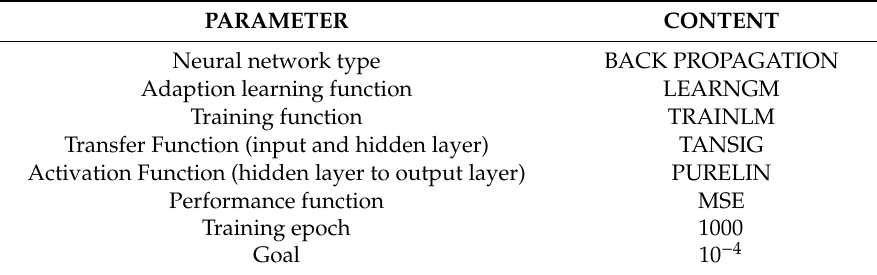
Table 1. Artificial neural network (ANN) training